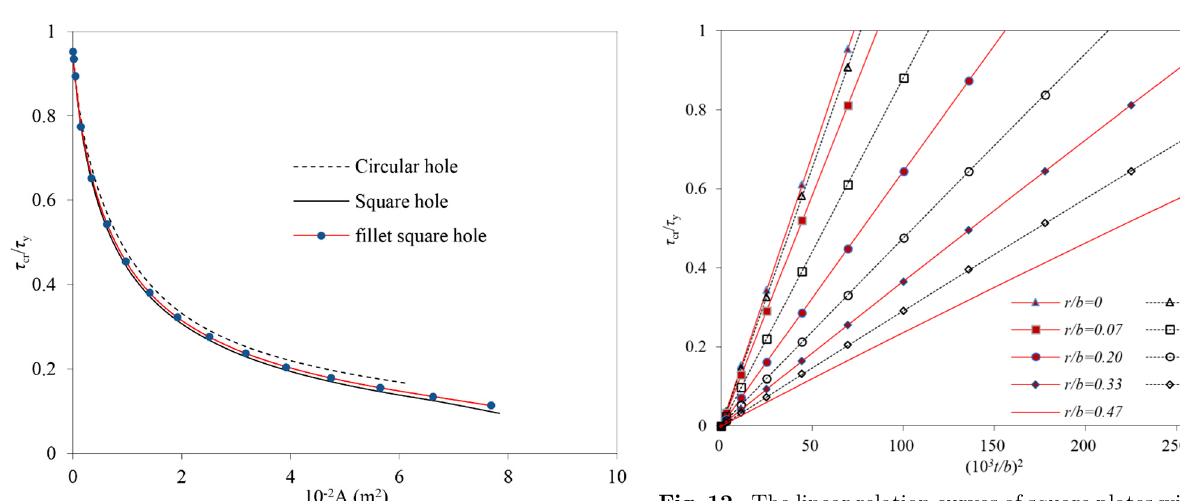
Fig. 12. The linear relation curves of square plates with circular holes.